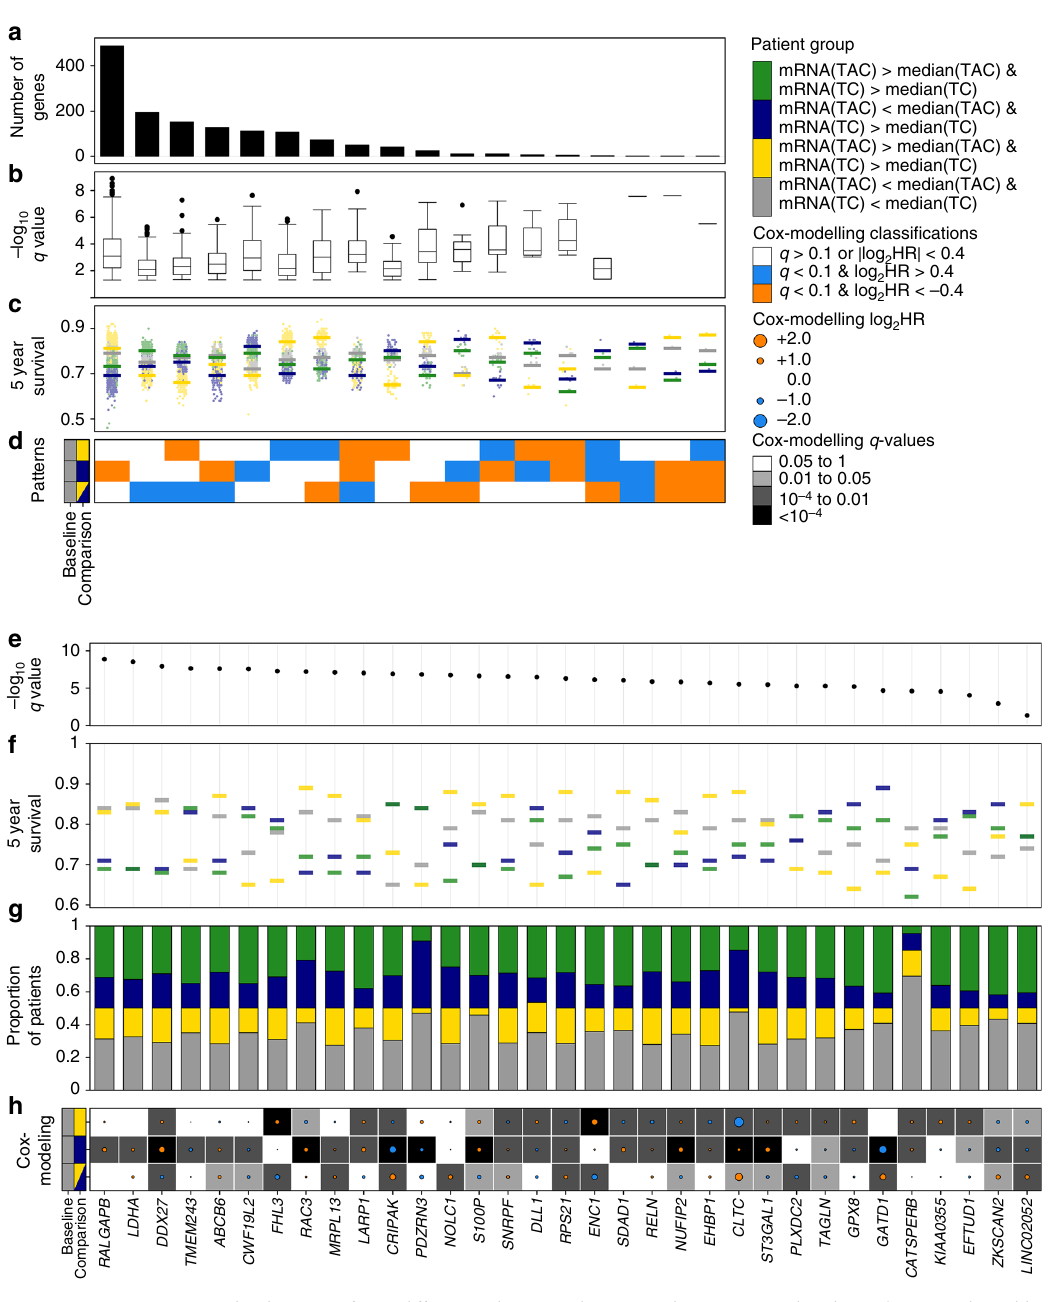
Fig. 4 TC – TAC gene interactions. Genes that have signi fi cant differences between their TC and TAC mRNA abundance (terms with Wald q -value < 0.1 & |log 2 HR| > 0.4 from modelling the TC – TAC interaction) are grouped by Cox modelling results ( a – d ) and the two genes from each group with the smallest log-rank q are elaborated on ( e – h ). Gene classi fi cations are described by the number of signi fi cant genes in each classi fi cation ( a ), log-rank q values ( b ), the proportion of patients who were alive at 5 years ( c ) with the median 5-year survival shown with the line and the Cox modelling results pattern that de fi nes the group of genes ( d ). Selected genes are described again by log-rank q value ( e ) and 5-year survival ( f ) this time of the individual genes, also the proportion of patients in each patient group ( g ) and HR and the Wald q values from the post hoc Cox modelling ( h